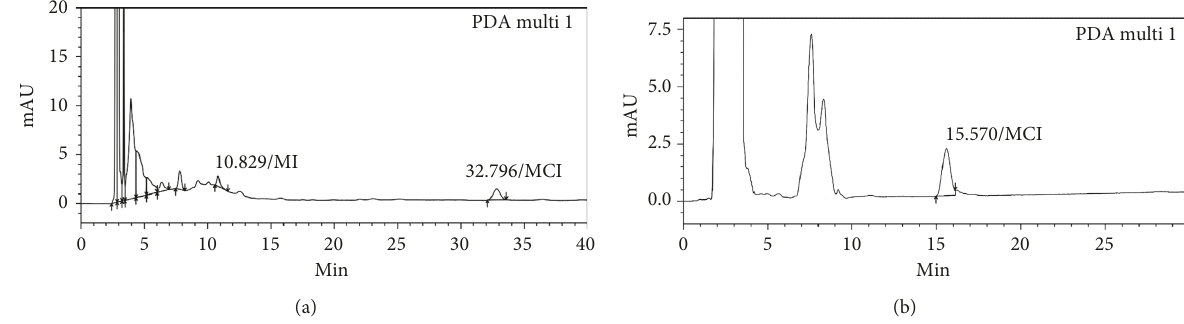
Figure 1: Some chromatograms obtained after analyzing placebo spiked with standard of MI and MCI during method development: (a) analysis on C18 column, sample preparation as per 2.4.2–Retention times were long for both analytes, especially MCI (more than 30minutes); (b) analysis on biphenyl column with chromatographic conditions as per 2.3.1, sample was extracted directly with mixture methanol–0.02M phosphate buffer solution pH 3.0 (30: 70, v: v) without previous dispersion in isopropyl myristate and cold centrifuging; peak of MI (retention time about 7.7minutes) was not